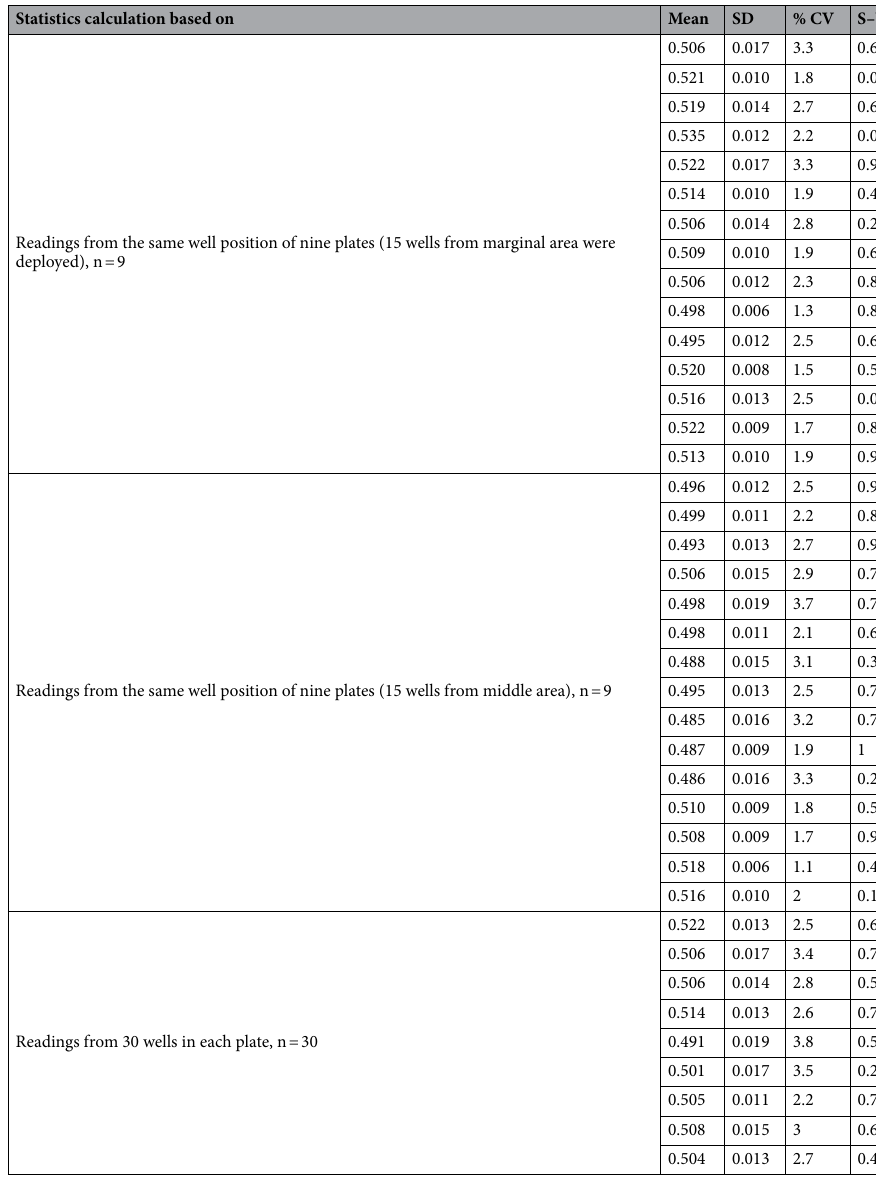
Table 1. Statistics of culture controls in the chemical screening. Culture controls were allocated to 30 wells covering marginal and middle areas of the plate and were repeated on nine plates. Assay readings were recorded (Supplementary Table S2), and standard statistics were calculated using IBM SPSS